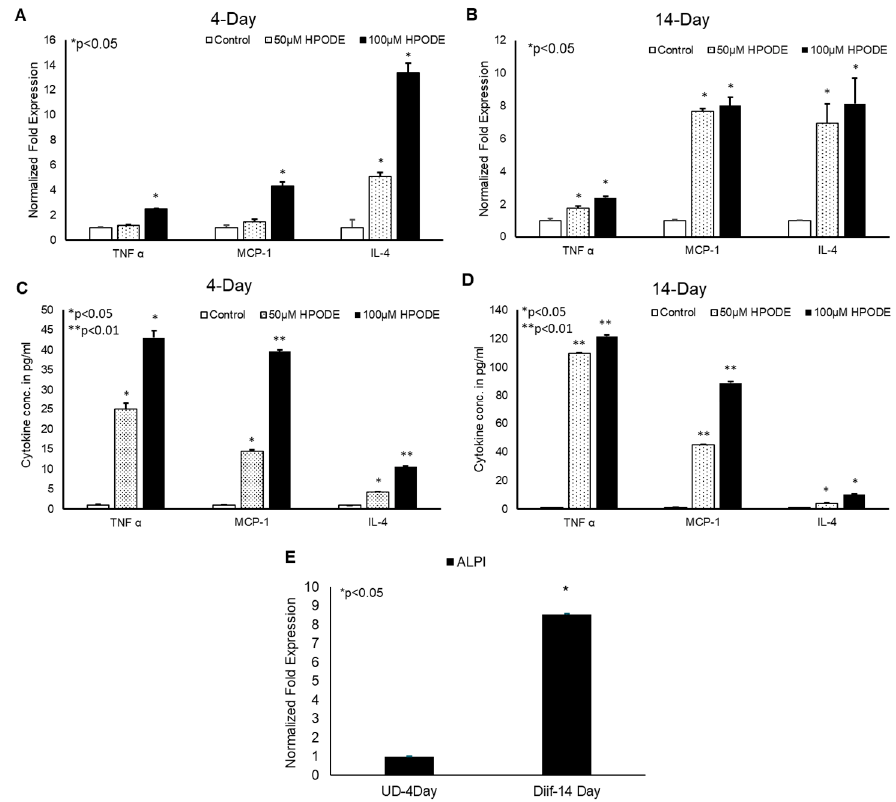
Figure 1. 13-HPODE induces pro-inflammatory gene expression in undifferentiated and differentiated Caco-2 cells. ( A , B ) 4-day (undifferentiated) and 14-day (differentiated) Caco-2 cells were incubated with increasing concentrations (50 and 100 µM) of 13-HPODE (HPODE) for 24 h. RNA was isolated and qPCR analysis was performed assessing for pro-inflammatory TNF- α , MCP-1, and IL-4 gene expressions using appropriate primers. ( C , D ) Secretion of pro-inflammatory cytokine levels was measured by ELISA. ( E ). Caco-2 cell differentiation was confirmed by ALPI expression. Results are represented as mean ± SEM and significance was considered as * p < 0.05, ** p<0.01 . TNF- α , Tumor necrosis factor alpha; MCP-1, Monocyte chemoattractant protein-1; IL-4, Interleukin-4; ALPI, Intestinal alkaline phosphatase.